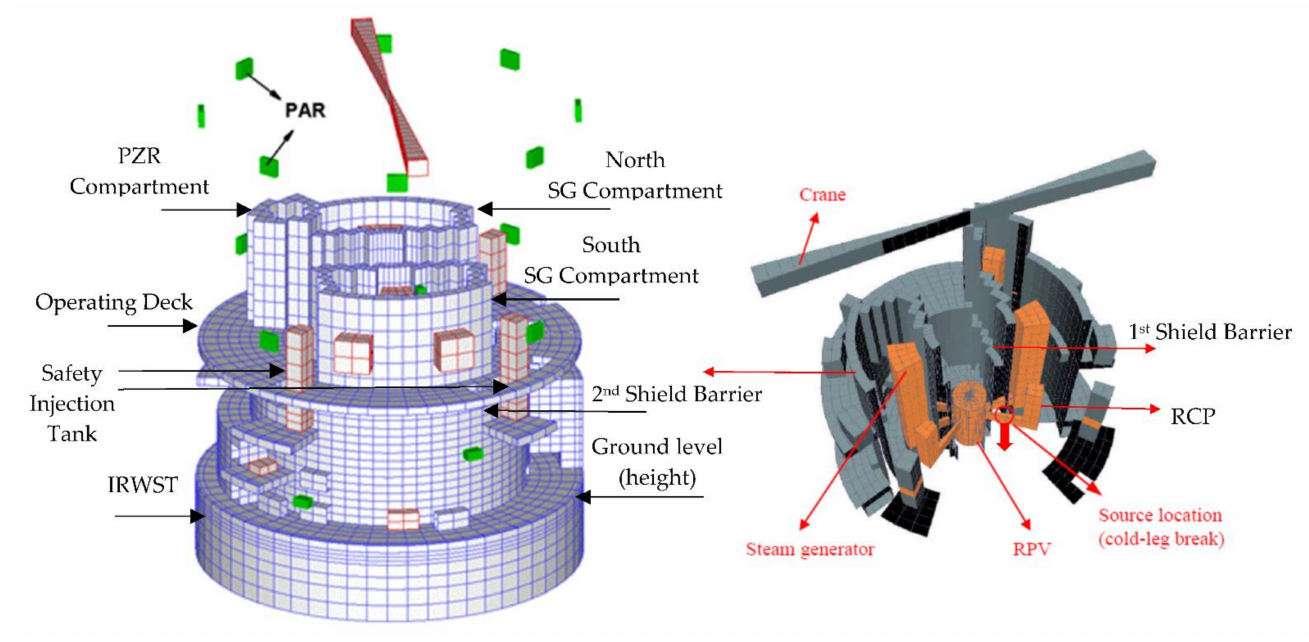
Figure 1. Internal geometry configuration of the APR1400 containment